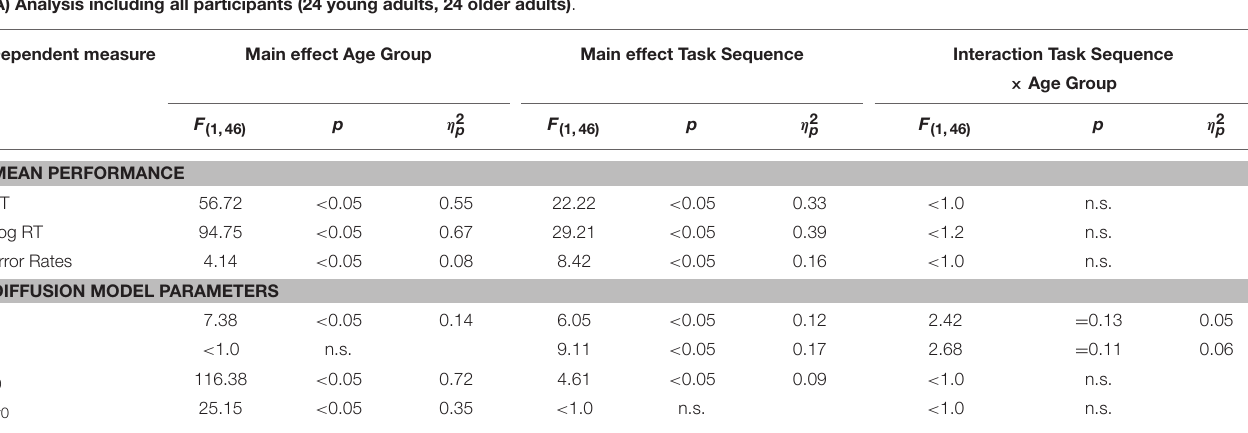
TABLE 1 | Analysis of task inhibition: Results of the 2 × 2 ANOVAs with within-subjects variable Task Sequence (ABA, CBA) and between-subjects variable Age Group (young adults, older adults). (A) Analysis including all participants (24 young adults, 24 older adults)